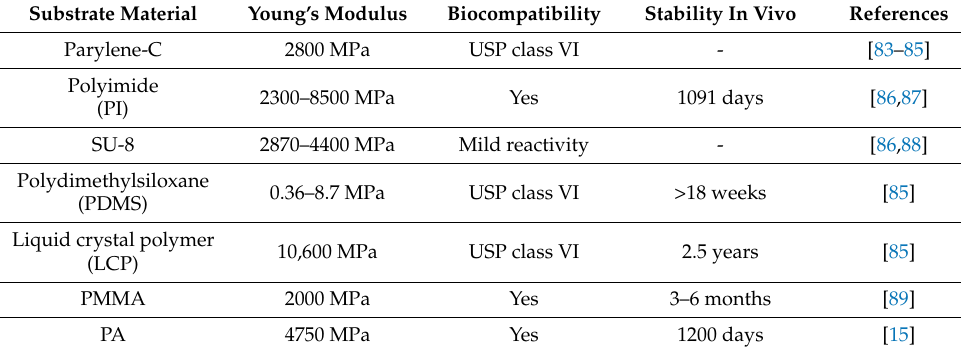
Table 4. Different types of extracellular electrical signals in the brain [92] .